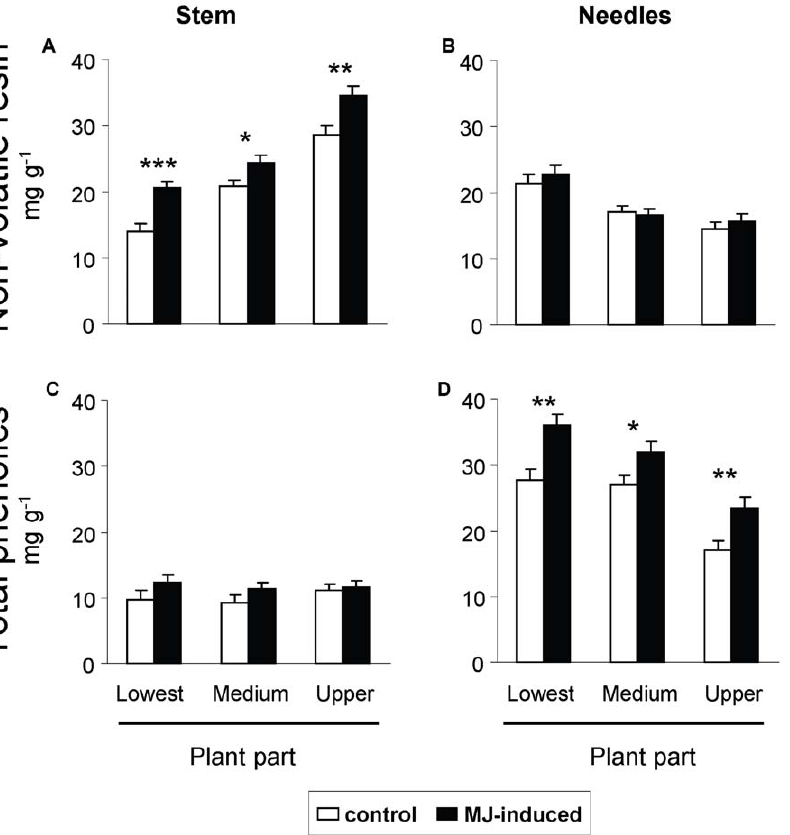
Figure 1. Allocation of constitutive and induced chemical defenses across different pine parts. Concentration of non-volatile resin in (a) the stem and (b) the needles, and total phenolics in (c) the stem and (d) the needles across three parts of the plants (basal, middle and apical upper part) in control (constitutive, white bars) and methyl-jasmonate (MJ) induced (black bars) P. radiata juveniles. Plants were destructively sampled 15 days after application of MJ. Bars are means 6 s.e.m. (N=36). Asterisks indicate significant differences within each plant part due to MJ-induction at P , 0.05 (*), P , 0.01 (**) and P , 0.001 (***).